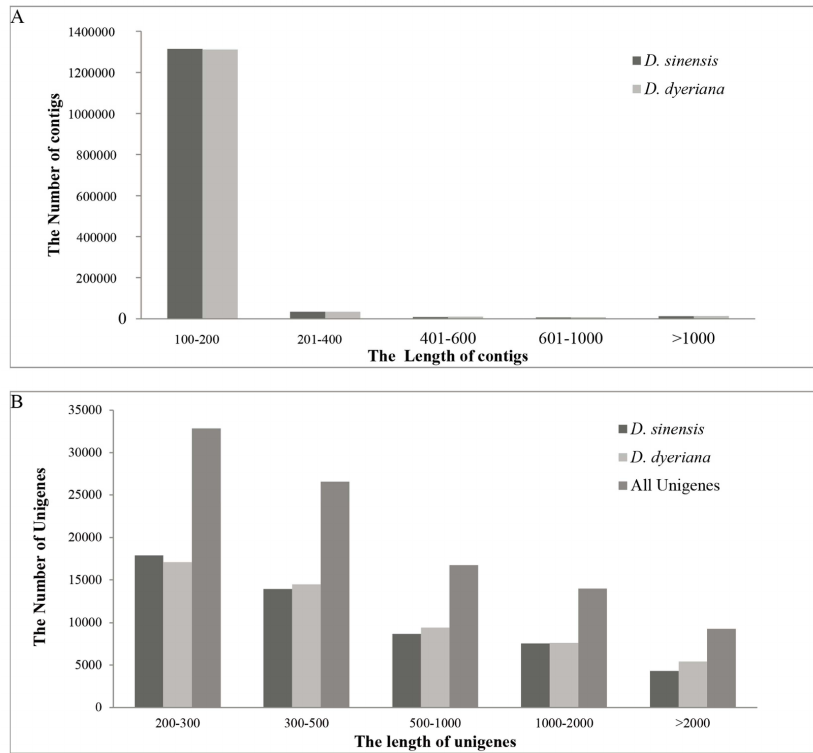
Figure 1. Length distribution of assembled contigs and unigenes. ( A ) Frequency distribution of the contig sizes from two Dipteronia species; ( B ) Size distribution of unigenes from two Dipteronia species. Table 1. Basic information of transcriptome reads, assembled contigs and unigenes for two Dipteronia species. Species